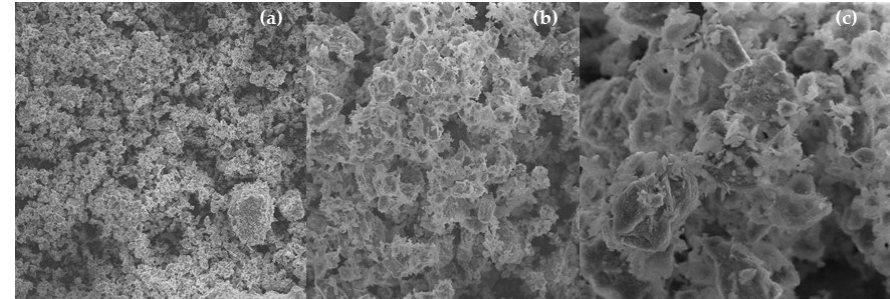
Figure 5. SEM of virgin pellets [MAG: 838 × ( a ); MAG: 3.33k × ( b ); MAG: 6.67k × ( c )].